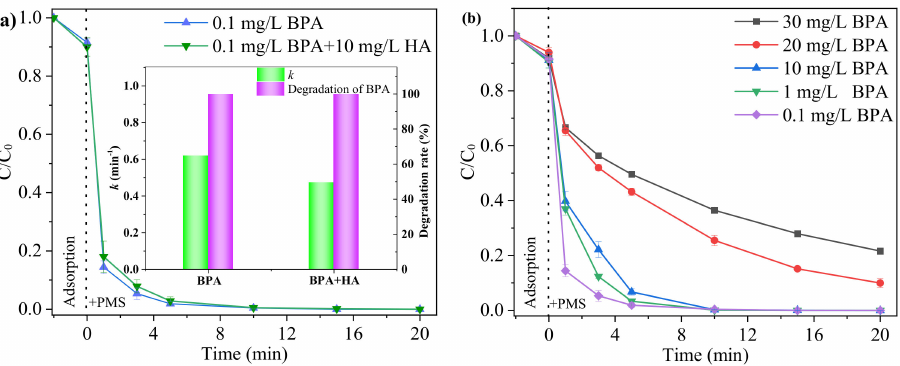
Figure 4. Effects of ( a ) HA and ( b ) BPA initial concentration on BPA degradation. Reaction conditions: [PMS] 0 = 0.10 mM, [Mn 2 O 3 ] 0 = 0.2 g/L, initial pH = 7.0 ±